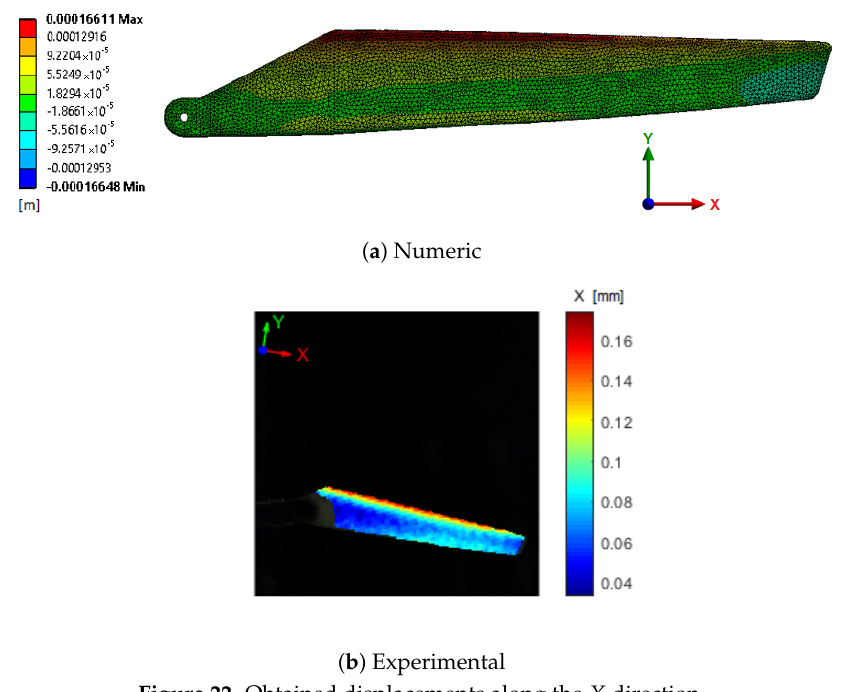
Figure 22. Obtained displacements along the X